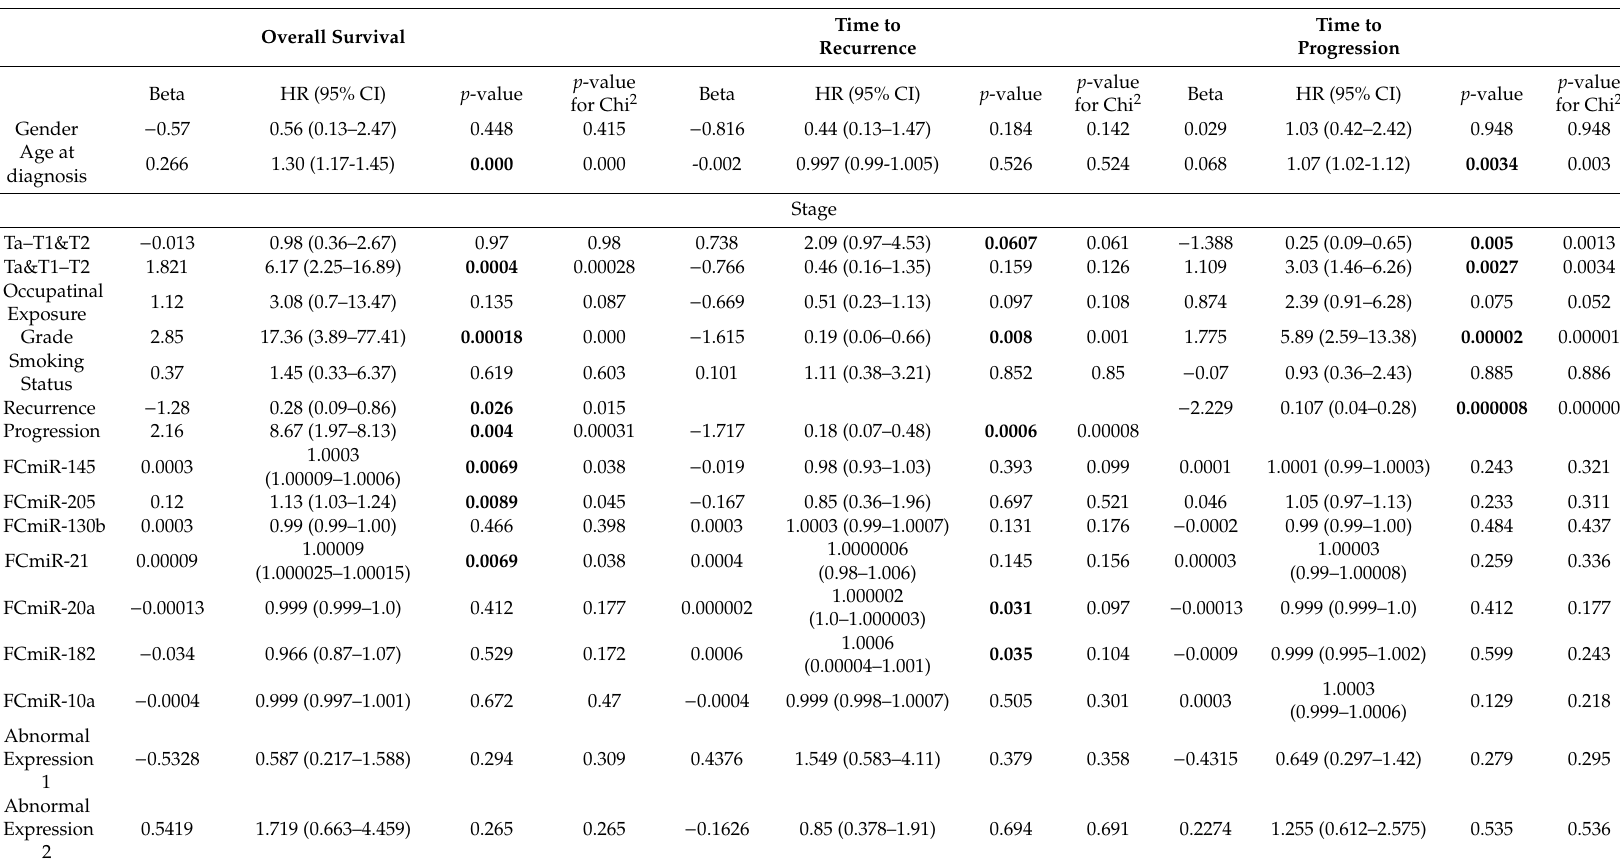
Table 4. Univaraite Cox regression analysis of potential predictor variables and overall survival, time to recurrence and time to progression in the group of patients (n =